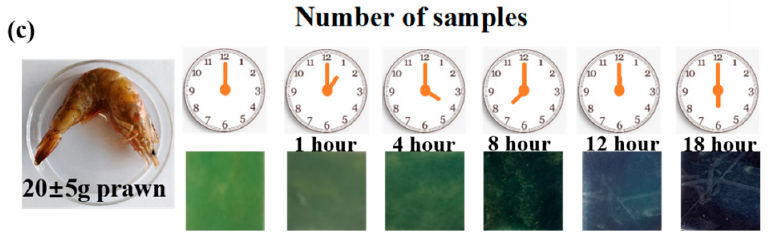
Figure 7. The response of PM2 sensors to exhaled breath of healthy patients and simulated patients with kidney disease ( a ) and the initial resistance of sensor without NH 3 ( b ); changes in the colorimetric sensors at different shrimp placement times ( c ).